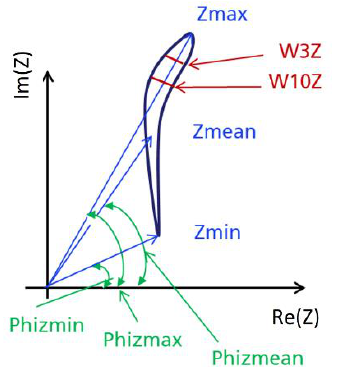
Figure 4. Schematic representation of the eddy current impedance loop [4]. Table 1. Subjective features of the eddy current analysis.